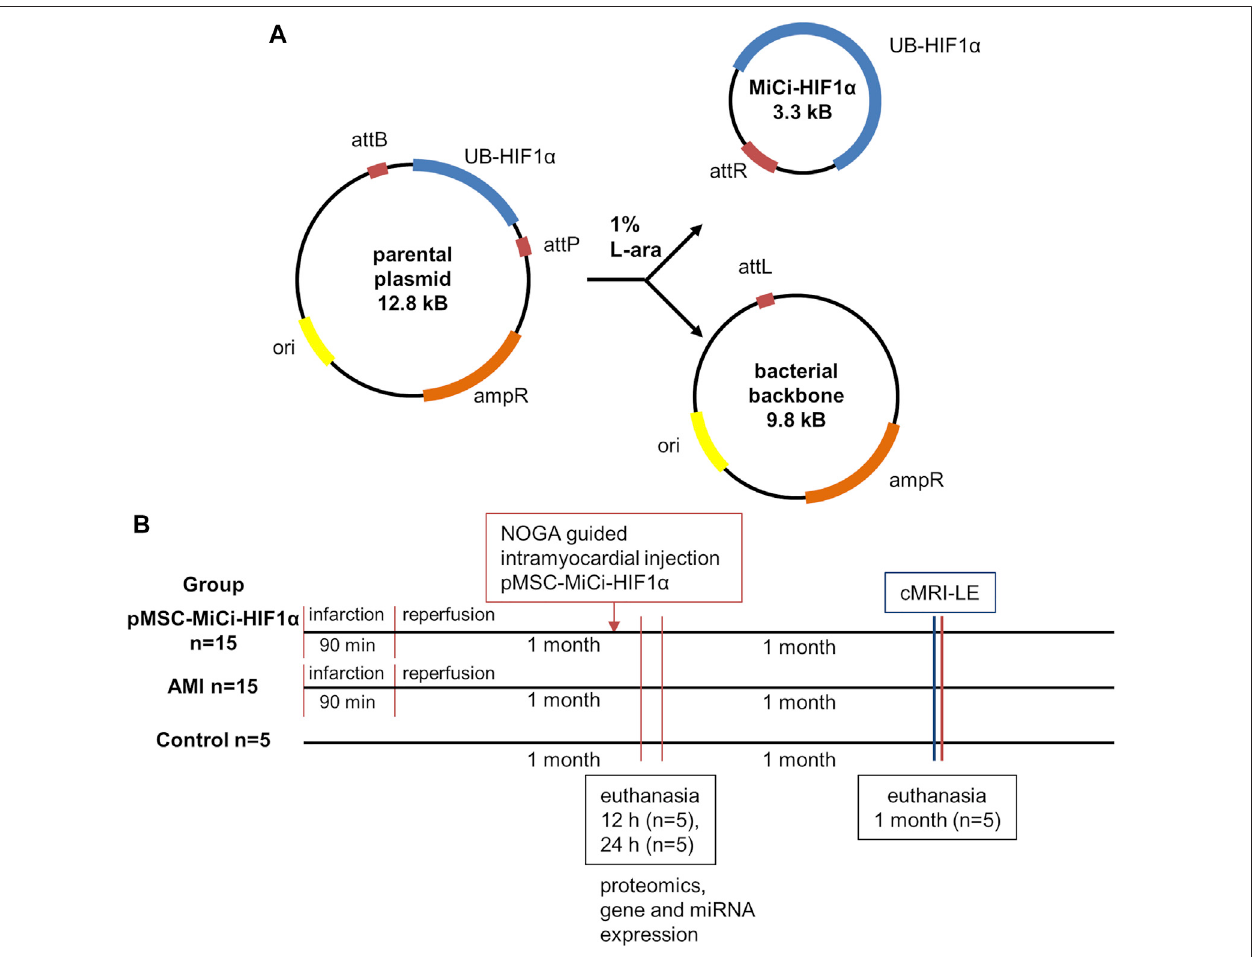
FIGURE 1 | Minicircle structure and study design. (A) Characteristics of the minicircle HIF-1 α (MC-HIF1 α ) expression vector. Upon bacterial expression, the MiCi- HIF-1 α isproducedbyintramolecularrecombinationbetweentheattBandattPsites.Asaresult,theexpressionvectorcarriersthetransgenewiththeubiquitinpromoter (UB-HIF-1 α ) and the right hybrid sequence (attR). The bacterial backbone including the antibiotic resistance gene (ampR), the origin of replication (ori) and the left hybrid sequence (attL) is subsequently linearized and digested by nucleases. (B) Study design with indications of follow-up procedures and analyses. (cMRI-LE: cardiac MRI late enhancement, miR: micro-RNA, mRNA: messenger RNA, IHC: immuno-histochemistry).